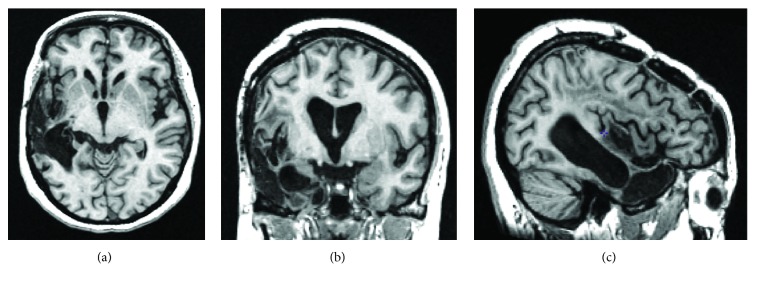
MR T1-weighted image of the patient's brain in (a) axial, (b) coronal, and (c) sagittal views. The patient presents with an extensive area of encephalomalacia within the left cerebral hemisphere involving the temporal and frontoparietal lobes with volume loss.